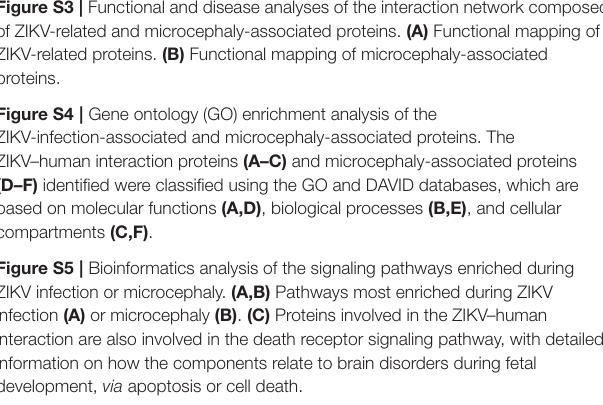
Figure S2 | The 212 proteins predicted to be associated with microcephaly that map to the interaction network. Figure S3 | Functional and disease analyses of the interaction network composed of ZIKV-related and microcephaly-associated proteins. (A) Functional mapping of ZIKV-related proteins. (B) Functional mapping of microcephaly-associated proteins. Figure S4 | Gene ontology (GO) enrichment analysis of the ZIKV-infection-associated and microcephaly-associated proteins. The ZIKV–human interaction proteins (A–C) and microcephaly-associated proteins (D–F) identified were classified using the GO and DAVID databases, which are based on molecular functions (A,D) , biological processes (B,E) , and cellular compartments (C,F) . Figure S5 | Bioinformatics analysis of the signaling pathways enriched during ZIKV infection or microcephaly. (A,B) Pathways most enriched during ZIKV infection (A) or microcephaly (B) . (C) Proteins involved in the ZIKV–human interaction are also involved in the death receptor signaling pathway, with detailed information on how the components relate to brain disorders during fetal development, via apoptosis or cell death. Figure S6 | RMSD–time curves for the ZIKV capsid protein (ZCP) in the 80 ns MD simulation indicated that the structure of ZCP was in a stable